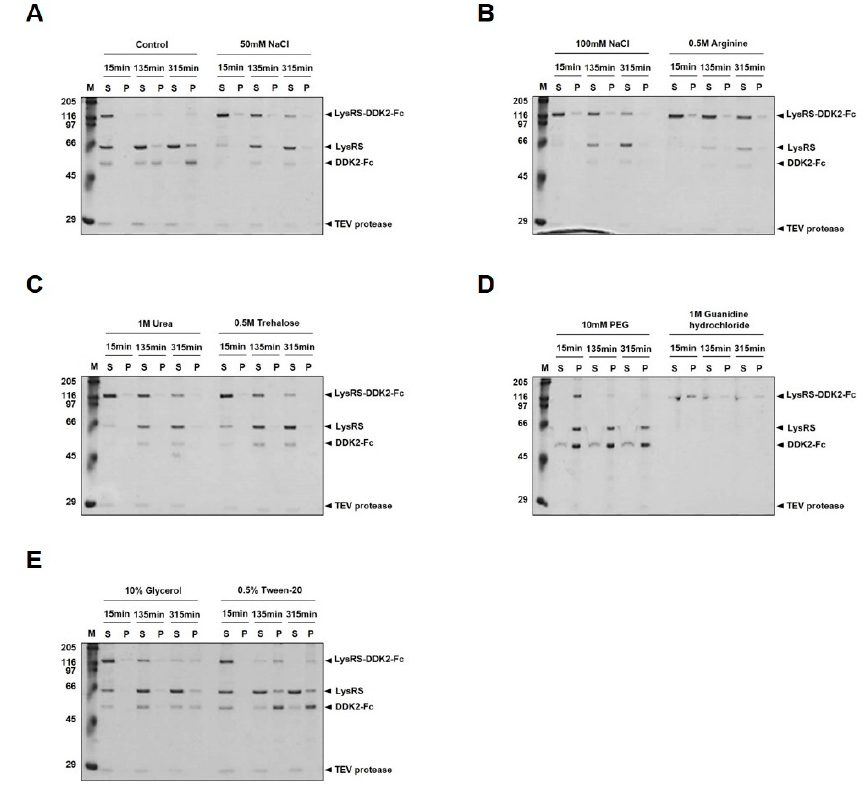
Figure 3. Effect of various excipients on TEV protease cleavage of LysRS-DKK2-Fc fusion protein. ( A – E ) The fusion protein was cleaved by TEV protease in the presence of various excipients known to influence protein solubility, including 50 or 100 mM NaCl, 0.5 M arginine, 1 M urea, 0.5 M trehalose, 10 mM polyethylene glycol (PEG), 1 M guanidine hydrochloride, 10% glycerol, or 0.5% Tween-20, in pH 9.0 buffer at 25 °C.